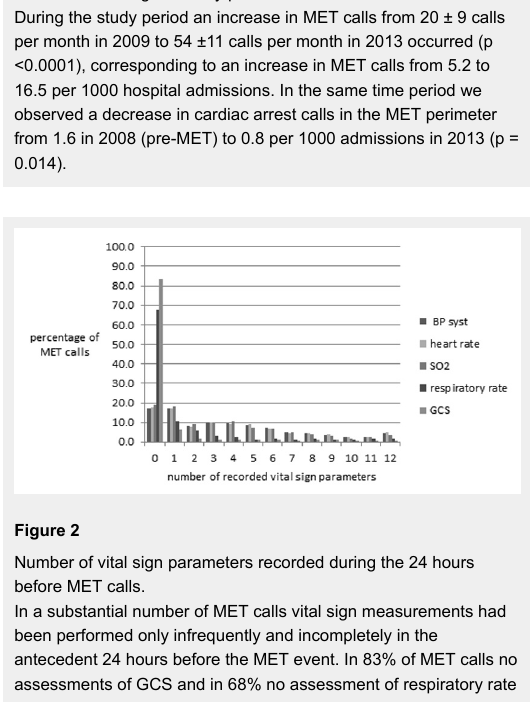
Incidence of MET calls and cardiac arrest calls per 1000 admissions during the study period.